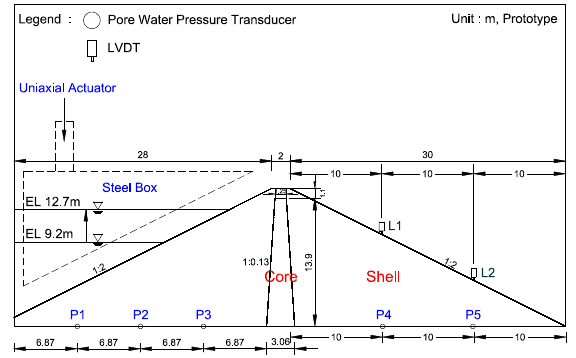
Fig. 3. Model configuration and sensor